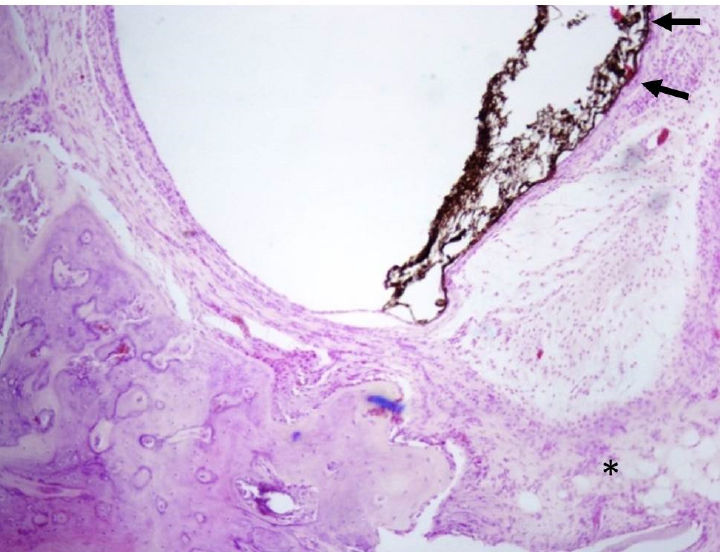
Figure 4. Histologic micrograph showing foreign material surrounded by a thin fibrous connective tissue capsule (arrows) and mild chronic inflammatory cell infiltrate composed primarily of lymphocytes (asterisk).